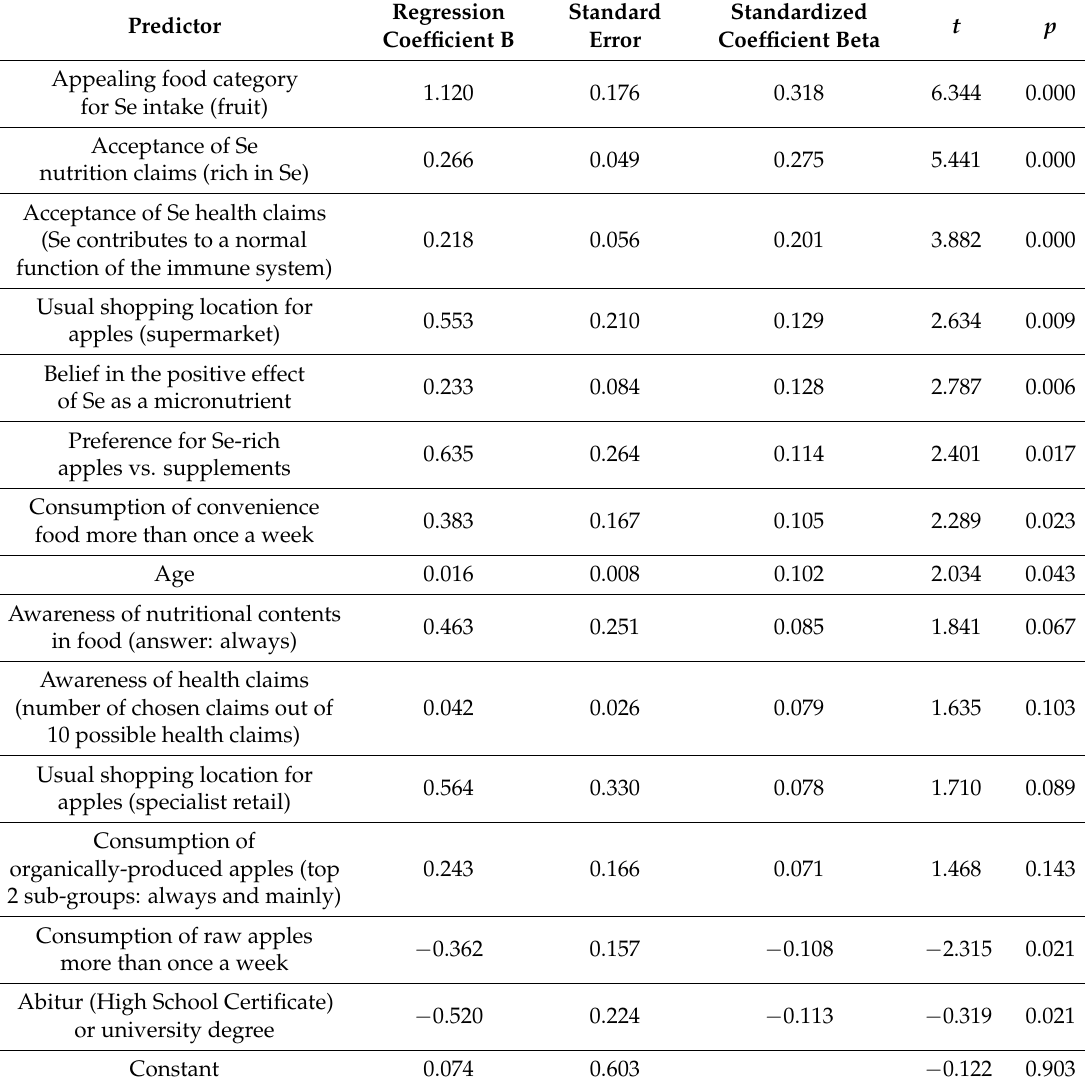
Table 3. Factors affecting the acceptance of the concept for Se-biofortified